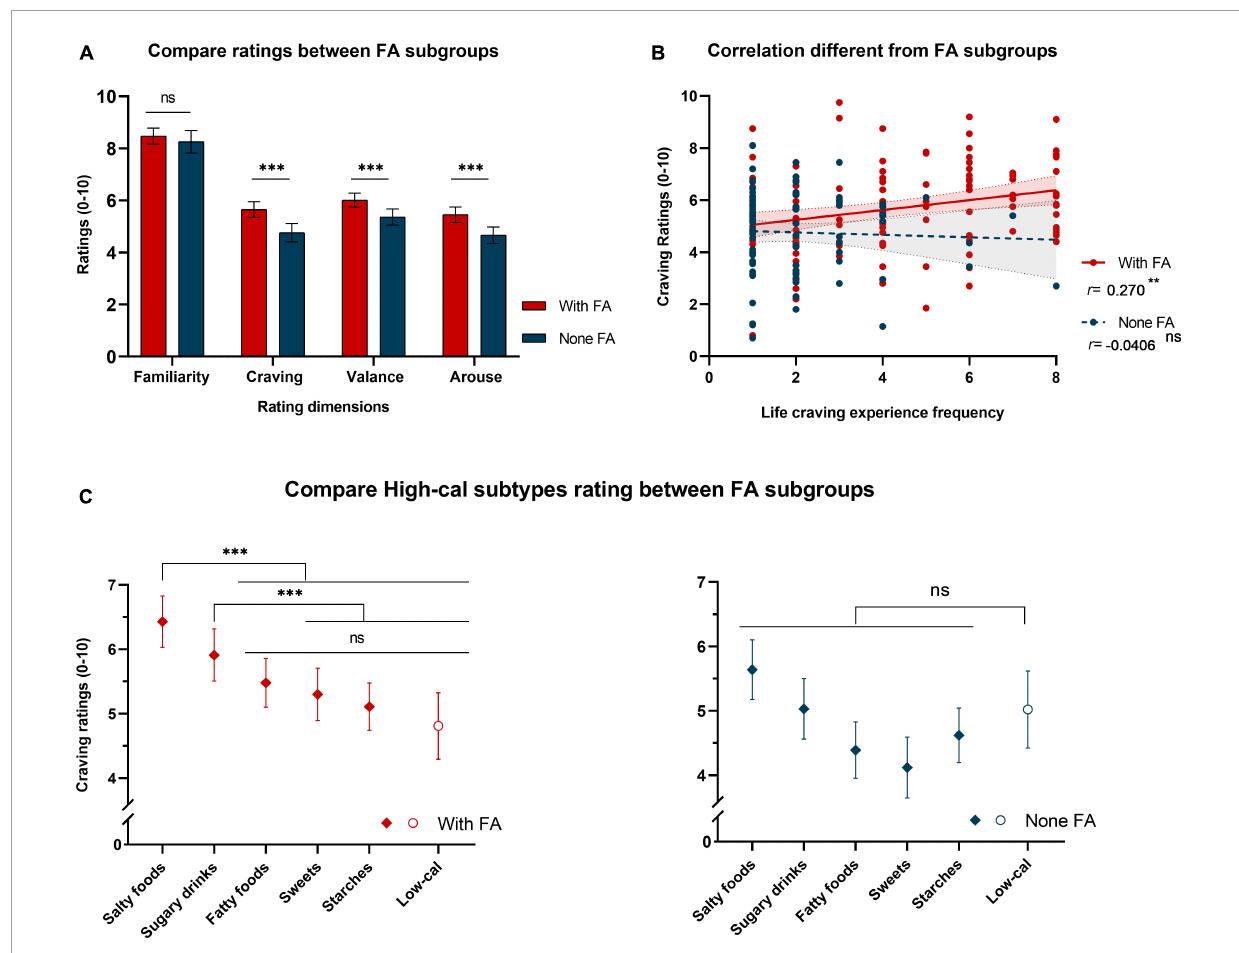
FIGURE3 Statistical analysis of PLCF data stratified by FA criteria. (A) Histogram of independent samples T -test results for each rating dimension. Between subgroups that did and did not meet FA criteria, ratings of high-calorie images showed significant differences in the craving, valence, and arousal dimensions but not in the familiarity dimension. The colors indicate different subgroups, with red denoting the subgroup that met FA criteria and blue denoting the subgroup that did not meet FA criteria [same in panels (A–C) ]. (B) Scatter chart of the Pearson correlation between craving ratings of high-calorie food images and the frequency of cravings in daily life. The positive correlation between craving ratings of high-calorie food images and daily craving experiences (shown in Figure 2B ) only appeared in the subgroup that met FA criteria. A linear fit was conducted separately, and the shading within the dotted line indicates the 95% CI. (C) Dot plot of the estimated marginal means from the two-way repeated-measures ANOVA with the food subtype as a within-subject factor (six levels) and the FA classification as a between-subject factor (two levels). The greater cravings induced by salty food and sugary drink images (compared to low-calorie food images, shown in Figure 2C ) only appeared in the subgroup that met FA criteria. For all subplots, *** indicates p < 0.001, ** indicates p < 0.01, and “ns” indicates no significance. The error bar indicates the 95%